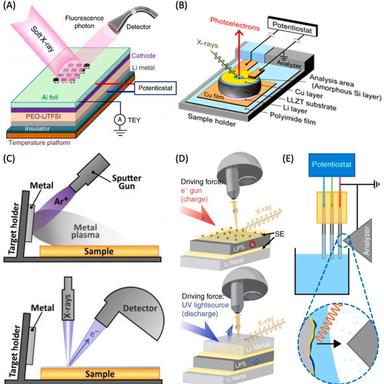
.1. Open cell measurement geometries for XPS and XAS of battery interfaces (a) Solid polymer electrolyte battery cell, where perforations in the Al current collector allow access to the reverse side of the cathode for XAS during electrochemical cycling; (b) Solid electrolyte cell for studying lithiation of sputtered Si electrode with XPS; (c) In situ sputter-deposition onto solid electrolytes for studying SEI evolution; (d) Virtual electrode approach on solid electr